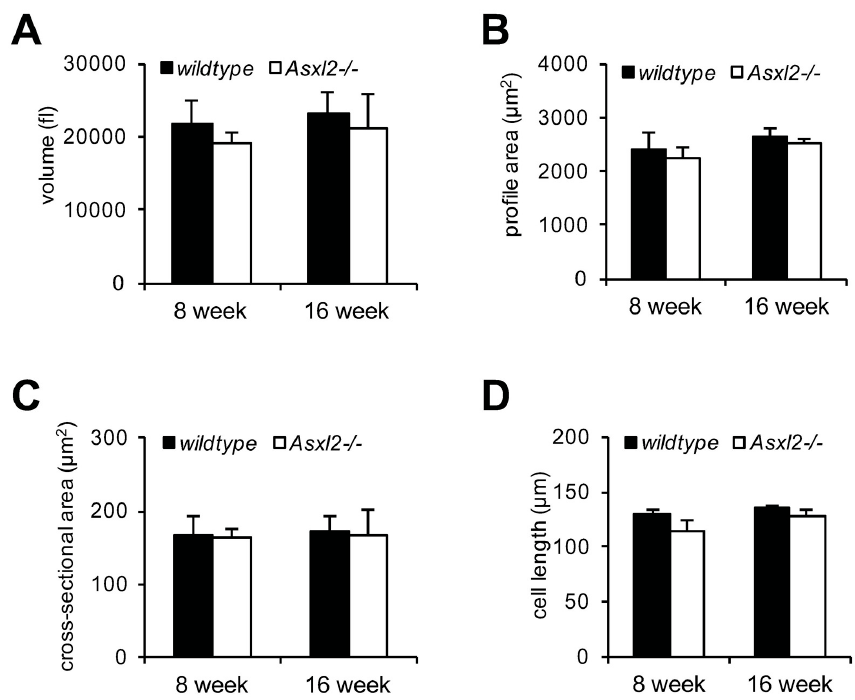
Figure 2. Lack of cardiomyocyte hypertrophy in Asxl2 − / − heart. Isolated cardiomyocytes from 8- and 16-week old wildtype and Asxl2 − / − hearts were assessed for: ( A ) volume; ( B ) profile area; ( C ) cross-sectional area; and ( D ) length. Sample size: 8-week wildtype, n = 4; 8-week Asxl2 − / − , n = 3; 16-week wildtype, n = 5; 16-week Asxl2 − / − , n = 3. Bars indicate standard deviation. No significant differences were observed (Student’s t -test).